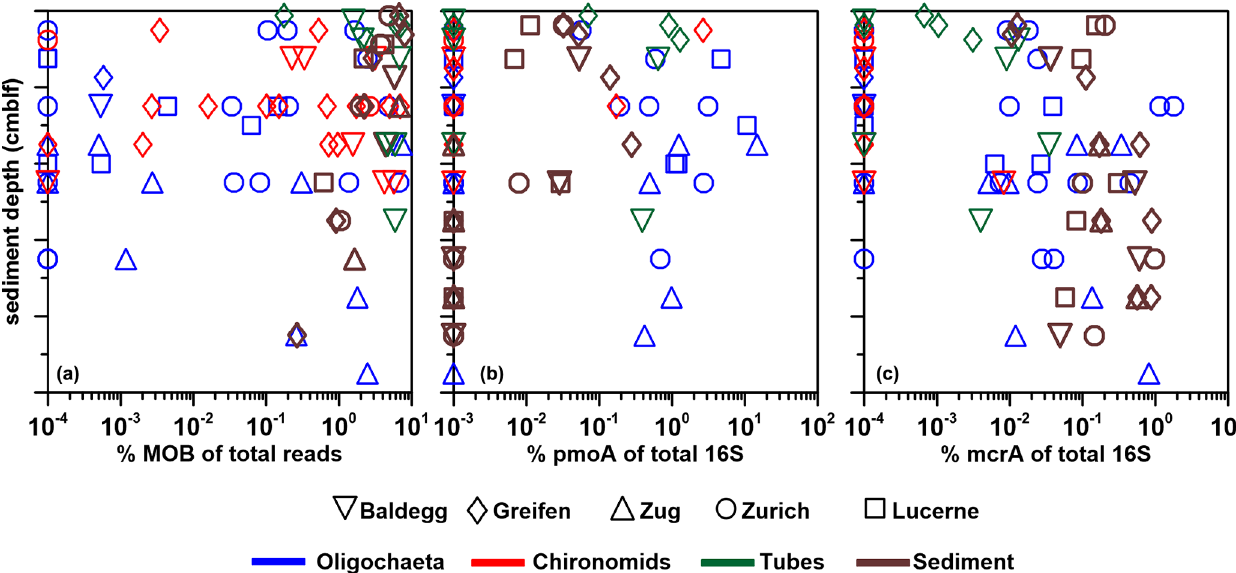
Figure 8. Ratios (expressed in %) of bacterial (BAC) 16S rRNA gene copy numbers (left panel), mcrA copy numbers (middle panel), and pmoA copy numbers (right panel) to total 16S rRNA gene copy numbers (sum of bacterial and archaeal 16S rRNA gene copy numbers). The three x axes differ in ranges and scales (linear and log). All sediment 16S rRNA gene values are from Han et al. (2020). Values on the lower limit of the x axis in the middle and right panels indicate samples in which mcrA or pmoA were below qPCR